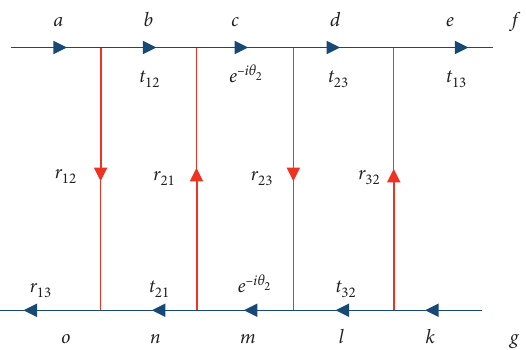
Figure 1: SFG illustration for a three-layer optical system.